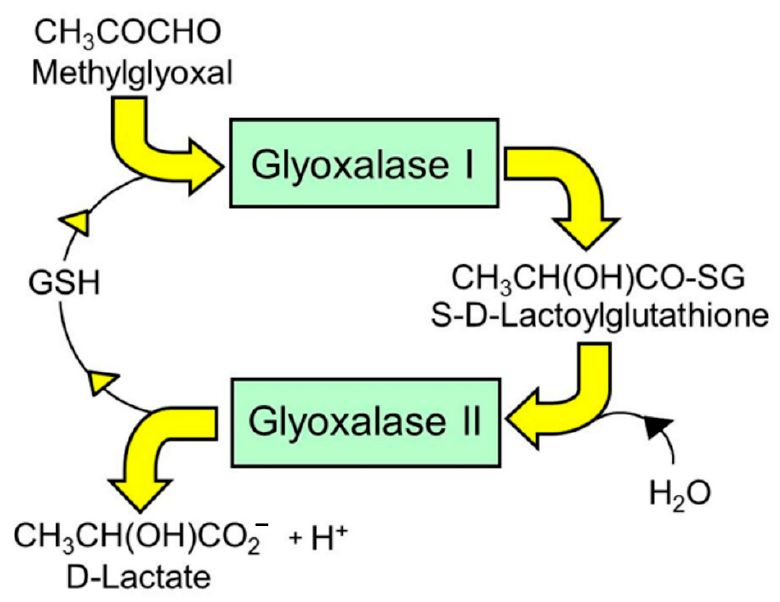
Figure 1. Metabolism of methylglyoxal by the glyoxalase pathway.